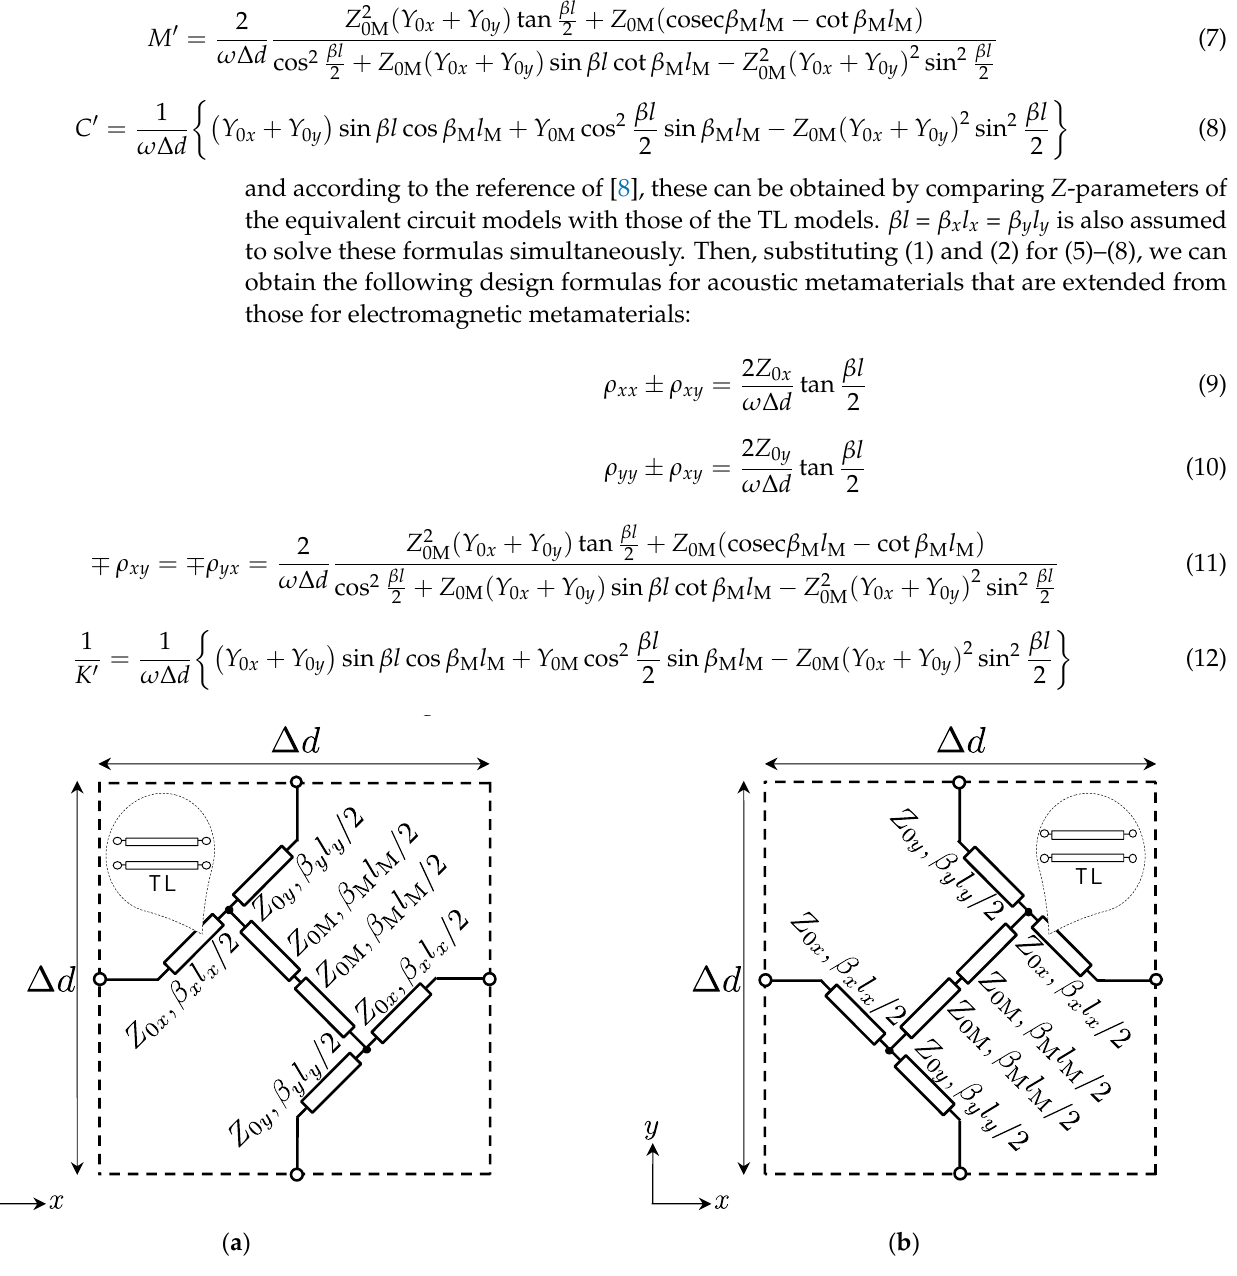
Figure 2. 2-D distributed TL models for determining the structural parameters of unit cells of full-tensor anisotropic acoustic metamaterials to be introduced from electromagnetic metamaterials. ( a ) ρ xx < 0 case; ( b ) ρ xx > 0 case. In the case of acoustic metamaterials, the phase constants ( β and β M ) of TLs correspond to those of acoustic waves.